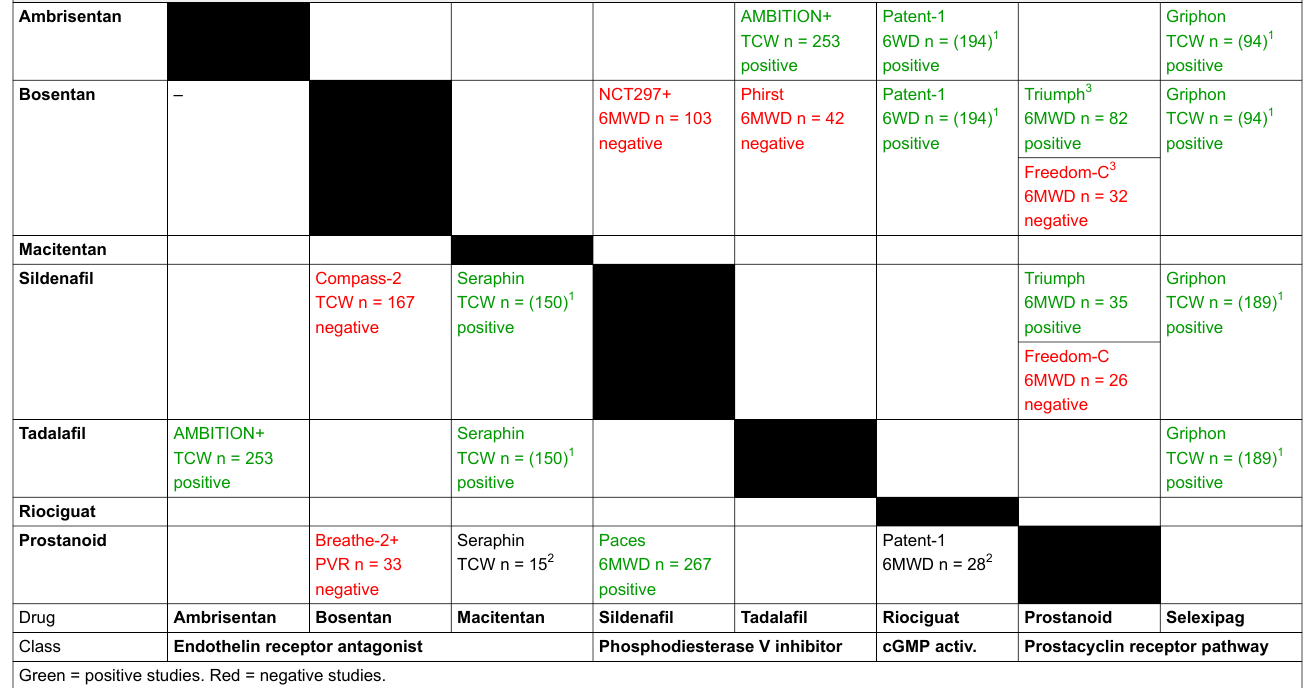
Green = positive studies. Red = negative studies. 6MWD = 6-minute walking distance; PVR = pulmonary vascular resistance; TCW = time to clinical worsening. 1 indicates that detailed numbers for each drug are not available. The figure in parentheses is for the whole class. 2 The number of patients is too low to prove